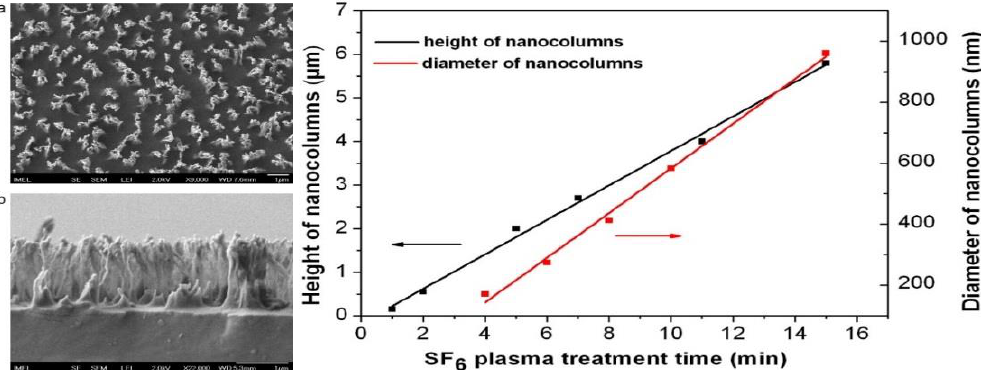
Figure 5. SF 6 plasma nano-textured PDMS. Left, ( a ) Top-down and ( b ) cross-section SEM images of a nano-textured polydimetylsiloxane (PDMS) surface obtained after a six min treatment under highly anisotropic conditions; Adapted with permission from [62]. Copyright 2010 Elsevier B.V. Right, evolution of the average height and diameter of nano-columns with process time; adapted with permission from [60]. Rights managed by AIP Publishing.